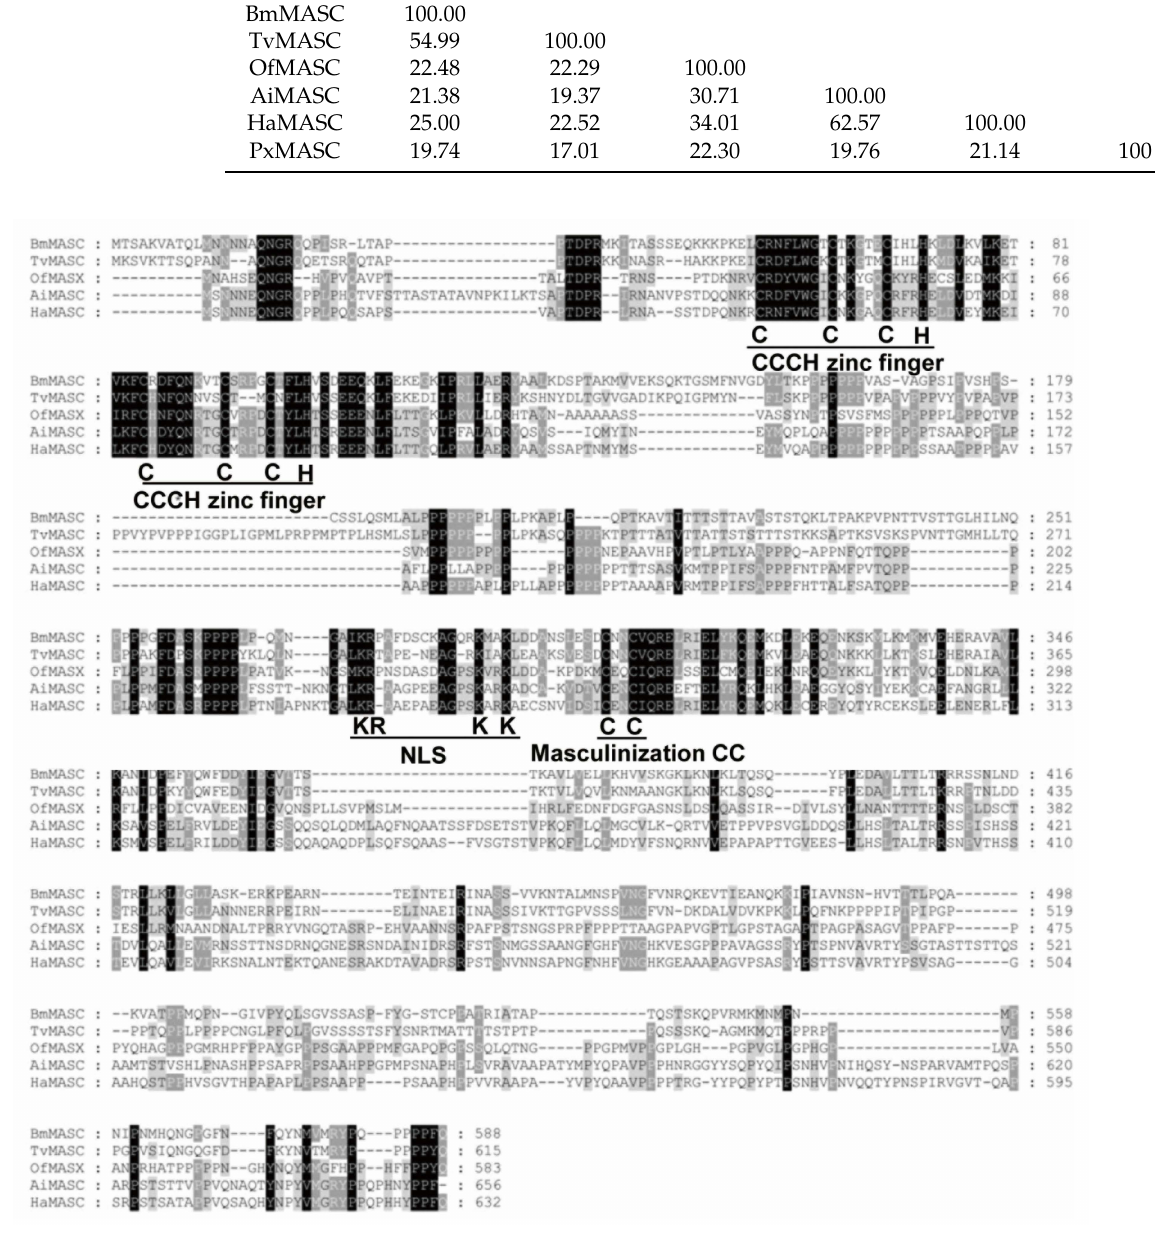
Figure 2. Amino acid alignment of HaMasc with four lepidopteran Masc proteins. Amino acids missed in any of the five Masc proteins are depicted by dashes. Amino acids conserved among all five Masc proteins are shaded in black, whereas those conserved among two to four Masc proteins are shaded in gray. The conserved tandem CCCH-type zinc fingers, nuclear localization signal (NLS), and masculinization CC are underlined. BmMasc = Bombyx mori Masc; TvMasc = Trilocha varians Masc; OfMasc = Ostrinia fumacalis Masc; AiMasc = Agrotis ipsilon Masc; HaMasc = Helicoverpa armigera